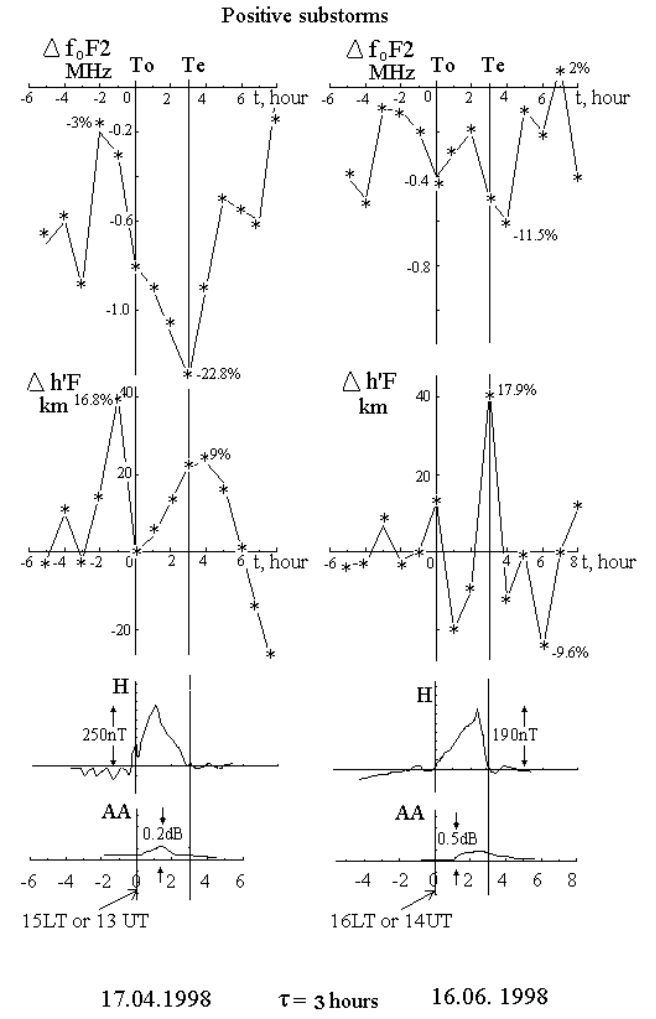
Fig. 4. The variations of 1 fo F2, MHz and 1h 0 F, km (only solid lines) for two positive substorms, together with the corresponding variations of the X -component and absorption measured at the Sodankyla observatory. The vertical lines mark substorm onset, T o , and the end of the substorm, T e . Asterisks are δ fo F2 (%) and δh 0 F (%) reduced to the maximum